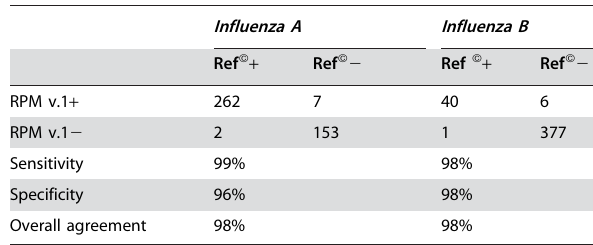
Table 1. Pathogens identified for 424 matched specimens-